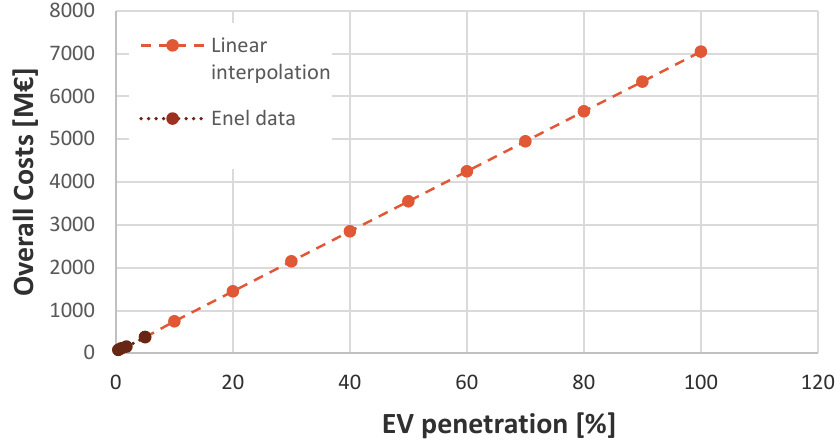
Figure 5. Infrastructural costs of electric mobility: data from the Enel foundation [73] and linear interpolation to extend these costs at higher penetration of EV.